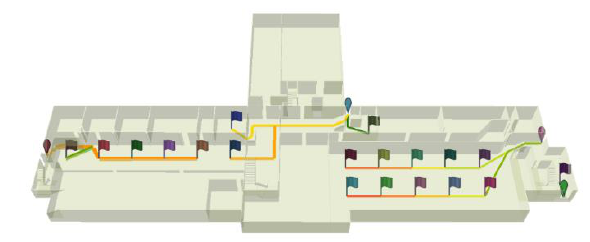
Figure 11. Generated Evacuation Basement Routes Figure 4.1 below shows the generated evacuation routes for